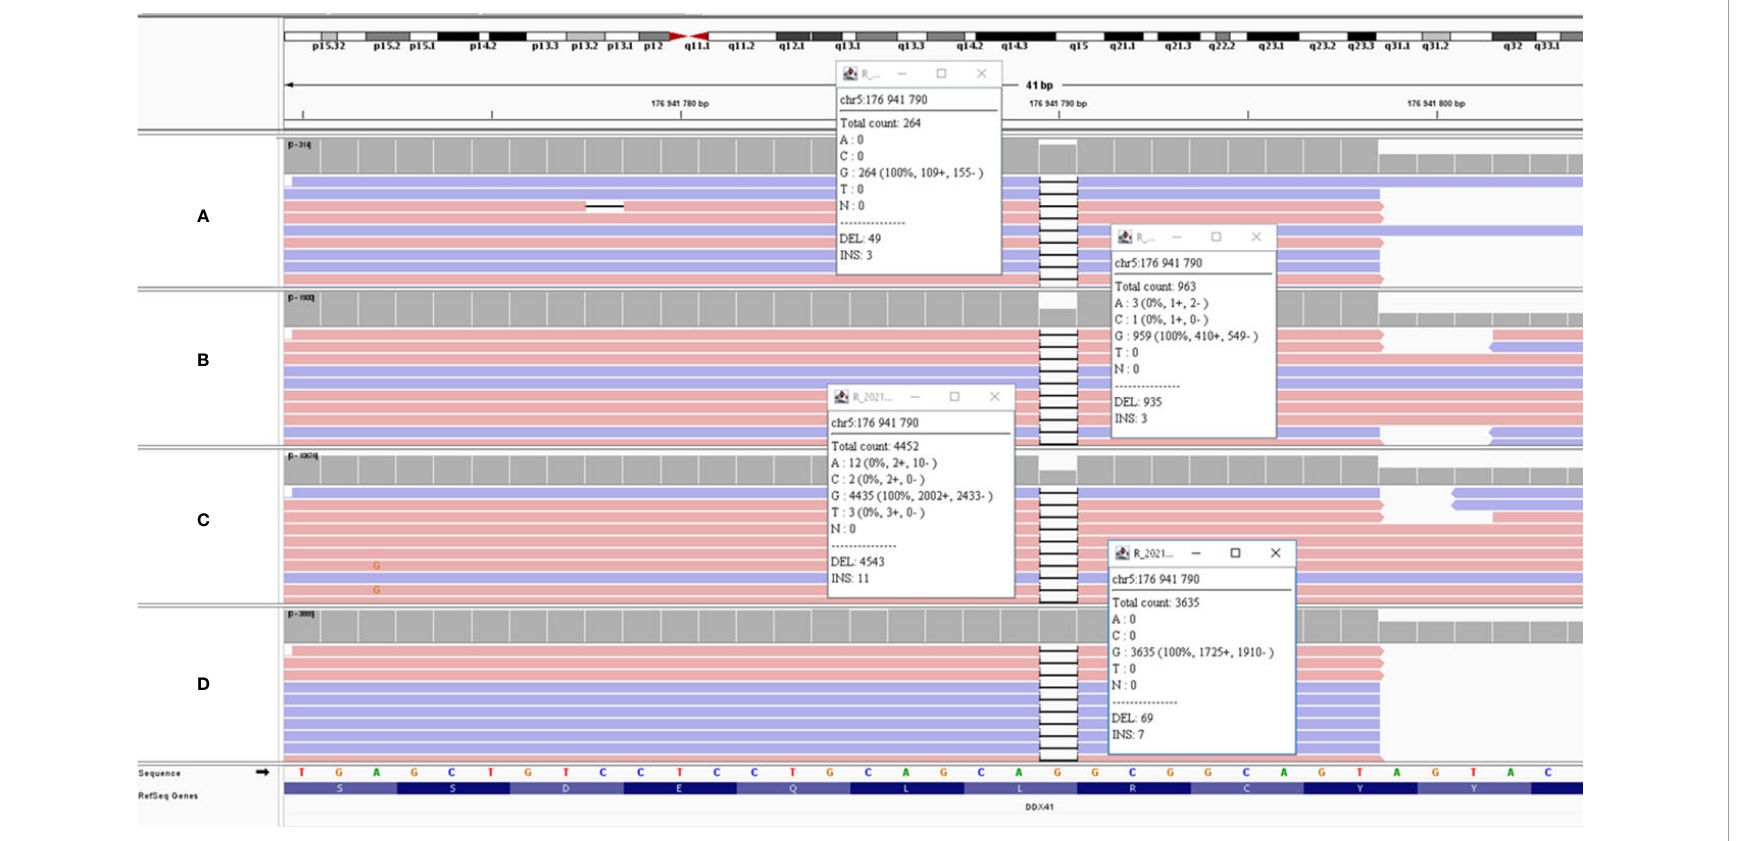
FIGURE 1 IGV view of DDX41 E268Dfs*21 mutation in different sample type of patient 4. (A) Saliva (VAF = 15.8%); (B) Skin fi broblasts (VAF=50%); (C) Bone marrow at diagnosis (VAF= 51.2%); (D) = bone marrow at relapse (VAF=1.9%). VAF of the mutation on saliva showed a chimerism, and germline nature is proven by analysis of skin fi